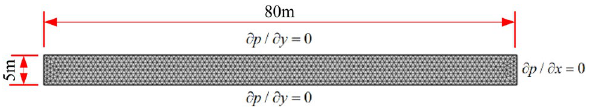
Figure 2. The model of numerical